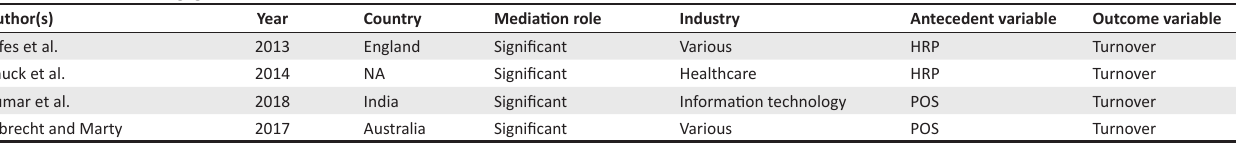
TABLE 5: Mediation of engagement on turnover